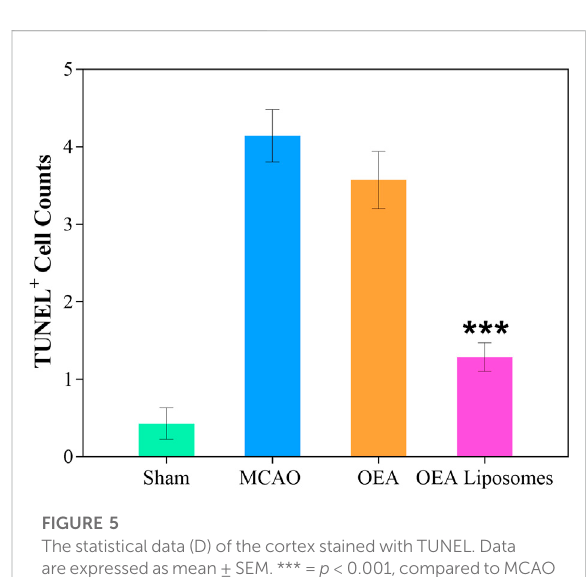
FIGURE 5 The statistical data (D) of the cortex stained with TUNEL. Data areexpressedasmean±SEM.***= p < 0.001,comparedtoMCAO